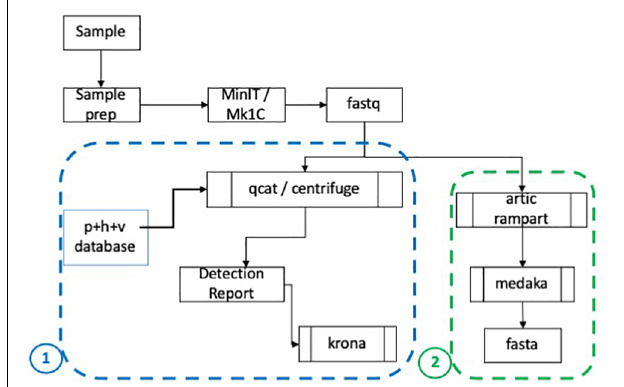
FIGURE 2 | CoV-2 analysis and assembly pipeline. A schematic showing analysis of sequencing data starting with sequencing using the MinION and MinIT and creation of basecalled data (fastq) (Wang et al., 2020). The fastq files are demultiplexed if appropriate and Centrifuge is used to map reads and deliver a report of the ranked organisms and visual report (Krona). The basecalled data is also analyzed using (Wu et al., 2020) RAMPART software and the sequences with high coverage are assembled using Medaka. Fasta files are generated for subsequent